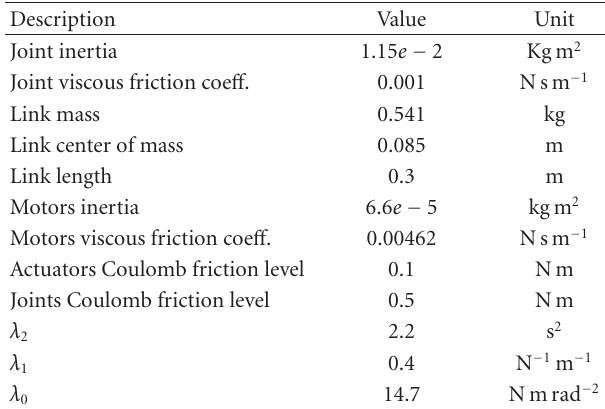
Table 1: Nominal parameters of the three-link planar manipulator.